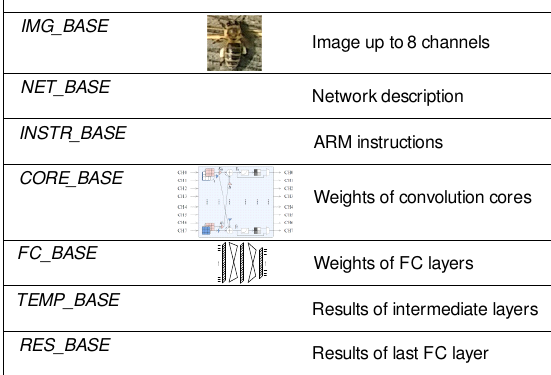
Figure 5. The arrangement of the base addresses in the on-board